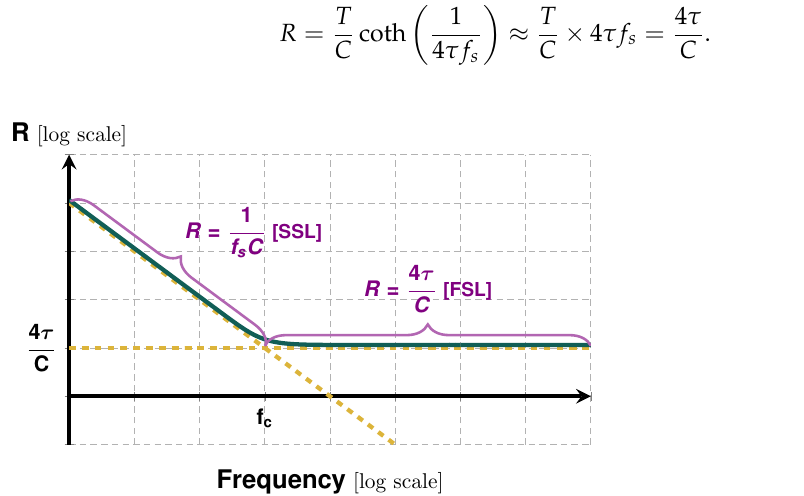
Figure 6. The equivalent resistance R with frequency for single-stage DCP when accounting for the switch